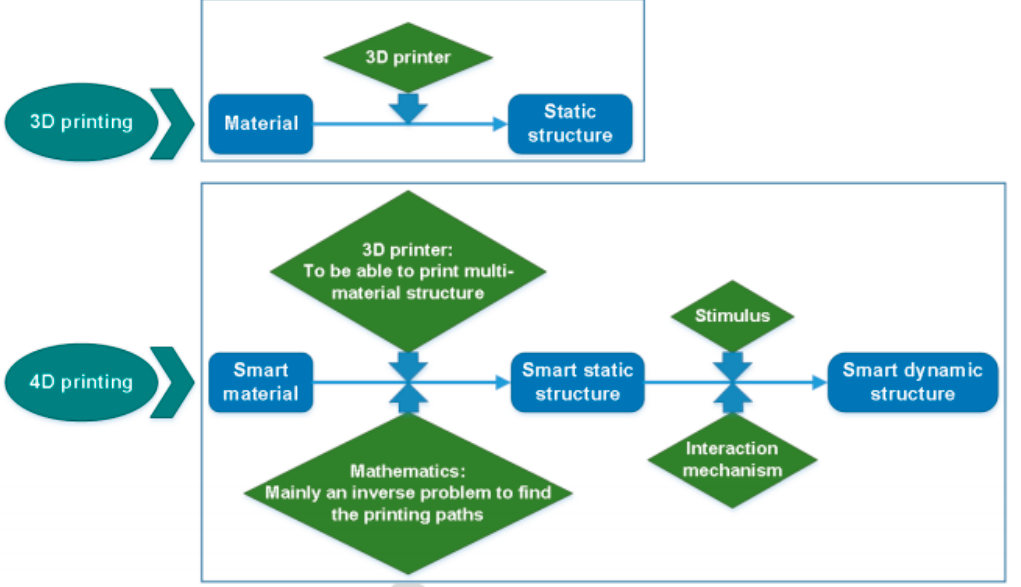
Figure 30. The differences between 3D printing and 4D printing (adapted with permission from reference [73]).